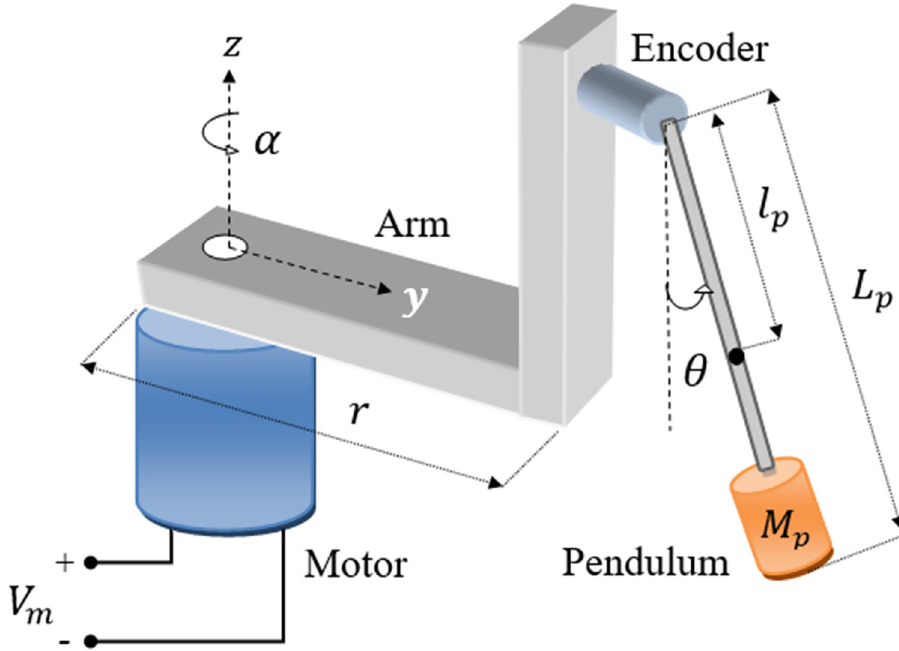
Fig 1. Schematic of a standard RIP